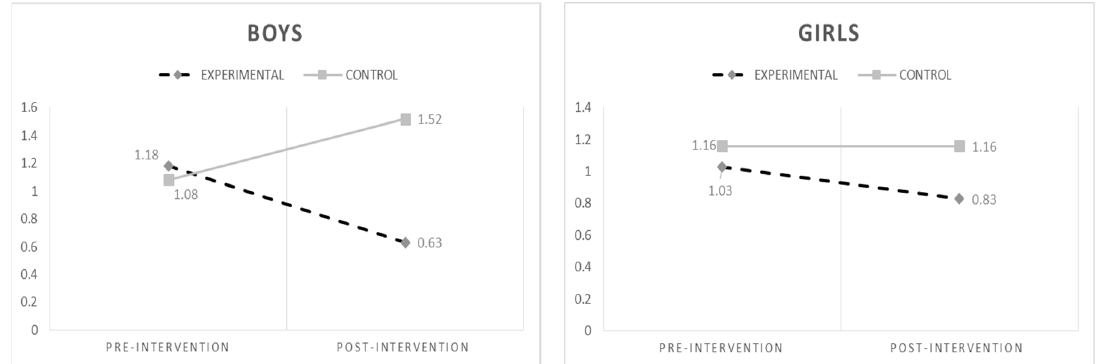
Figure 5 . Changes in cybervictimization over time by gender. Figure 5. Changes in cybervictimization over time by